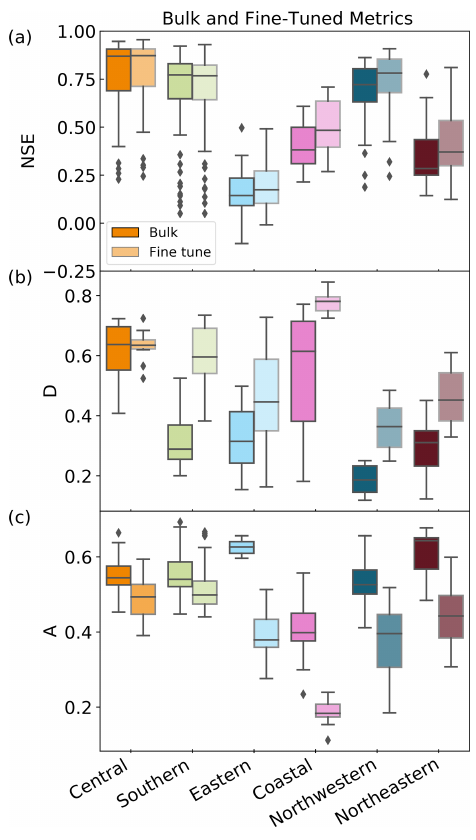
Figure 5. Comparison of metrics for both the bulk and fine-tuned models for each cluster of stream gauge stations, coloured accord- ing to the clusters shown in Fig. 2. (a) NSE of modelled stream- flow of each stream gauge station ( n = 226 across all six clusters). The central and southern clusters show the least amount of change between the bulk and fine-tuned models, while all other clusters increase NSE through fine-tuning (indicating improved model per- formance). For readability, the y axis was clipped at NSE = − 0 . 25; however, one station in the eastern cluster is below this threshold for both bulk and fine-tuned models (NSE = − 2 . 04 in the bulk model and NSE = − 0 . 70 in the fine-tuned model). This station is still in- cluded in all analyses and is not shown here for readability. (b) The D statistic for each model run for both bulk and fine-tuned model types ( n = 10 for each cluster). In the central cluster, the variance of D across model runs decreases through fine-tuning, indicating improved consistency between the fine-tuned central models. In all other clusters, D increases, indicating improved separation between information which is near/within basins as compared to information which is further away. (c) Sensitive area of the input as evaluated for each stream gauge station ( n = 226 across all six clusters). In all clusters, A decreases through fine-tuning, indicating that fine-tuned models are sensitive to smaller areas of the input as compared to the bulk